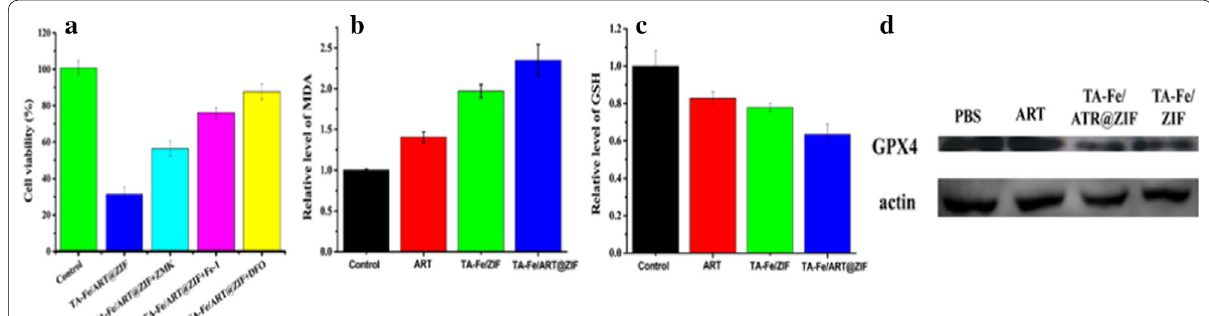
Fig. 6 a Inhibitors DFO (deferoxamine), Fer-1 (Ferrostatin-1) and Z-VAD-FMK rescued the viability of MDA-MB-231 cells under treatment with 100 μg/mL TA-Fe/ART@ZIF nanoparticles, respectively. b ART, TA-Fe/ZIF, and TA-Fe/ART@ZIF nanoparticles contributed to excessive MDA in MDA-MB-231 cells. c ART, TA-Fe/ZIF, and TA-Fe/ART@ZIF nanoparticles consumed intracellular GSH. d The expression levels of GPX4 proteins in MDA ‐ MB ‐ 231 cells treated with ART, TA-Fe/ZIF, and TA-Fe/ART@ZIF